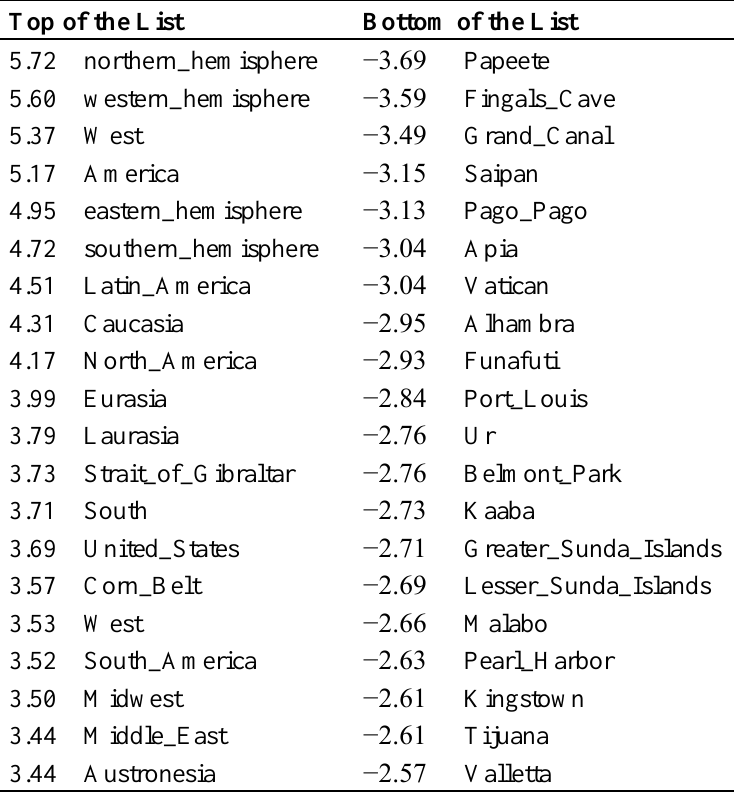
Table 4. Two ends of the sorted list of